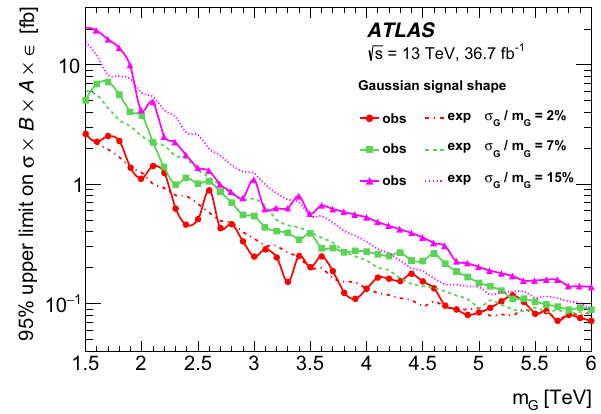
Fig. 5 Observed (solid lines) and expected (dotted lines) 95% CL upper limits on the visible cross-sections σ · B · A · ε in 36 . 7 fb − 1 √ s = 13 TeV as a function of the mass m G of the Gaus- of data at sian resonances with three different Gaussian widths between 2 and 15%. The calculation is performed using ensemble tests at mass points separated by 100 GeV over the search